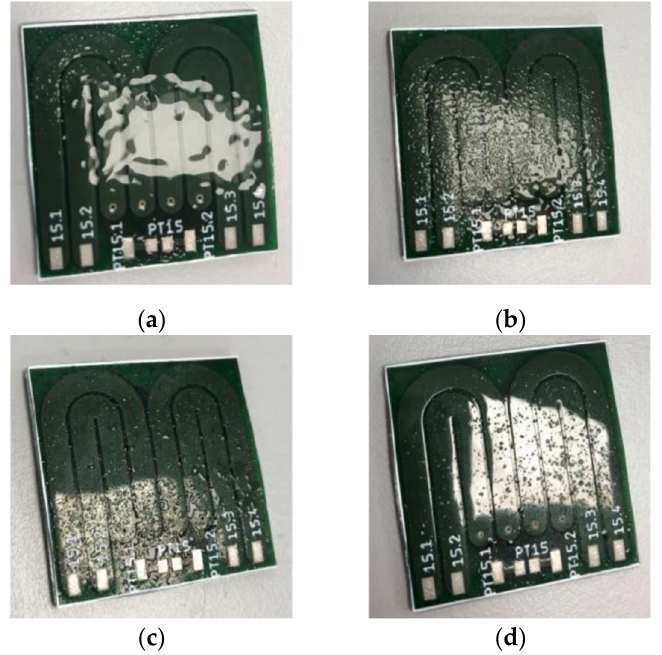
Figure 5. Photos of non-heated printed circuit boards immediately after spraying up hydrogel (1 spray pump, resp.), graded according to increasing spraying distance (5 cm, 10 cm, 15 cm and 20 cm) from top left to bottom right ( a – d